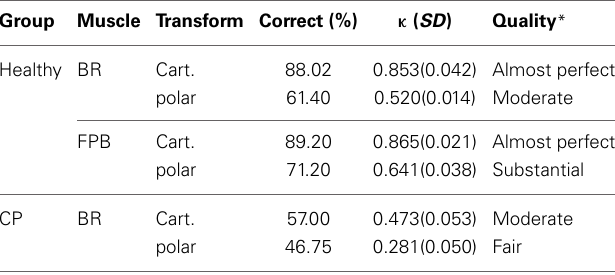
Table 3 | The responses of 4 listeners to vowels from 10 healthy subjects and 4 patients with dyskinetic CP.